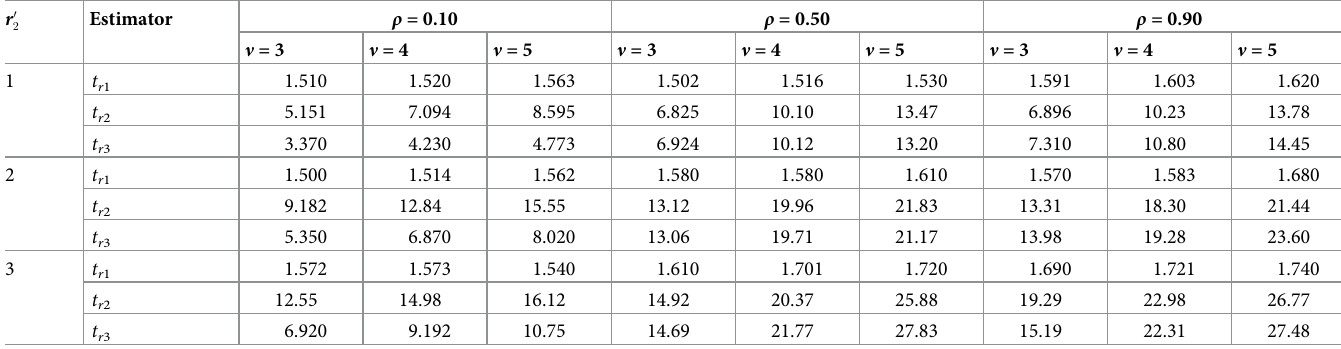
Table 1. RE of proposed class of estimators for Situation-I when k =